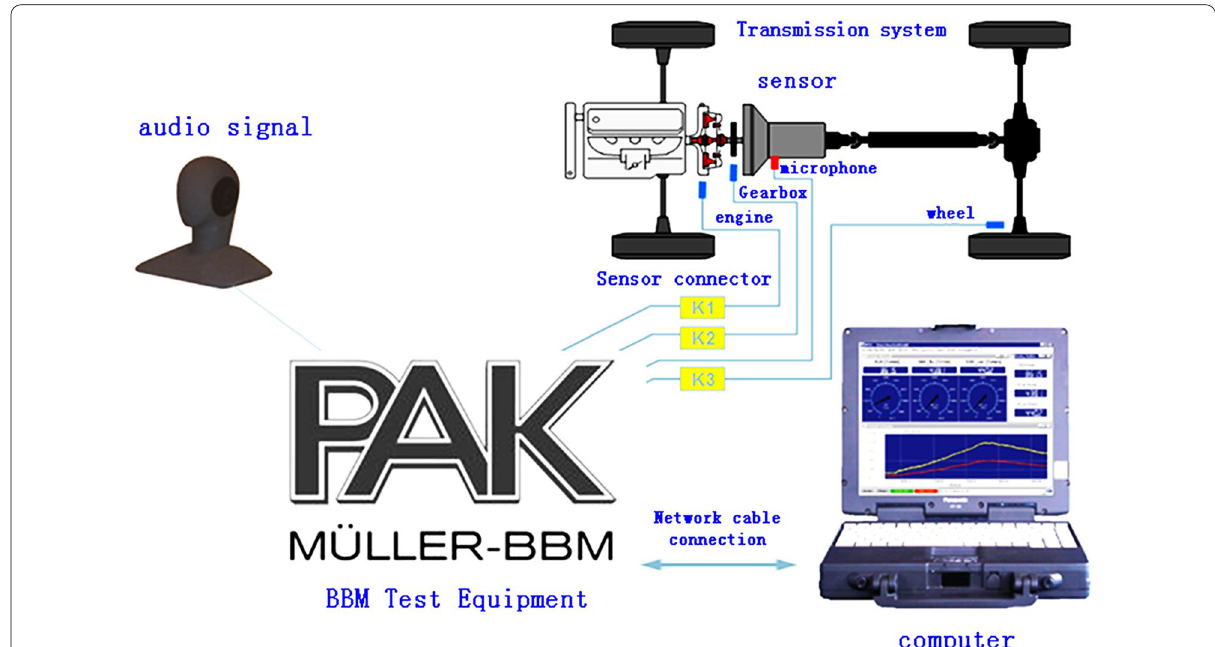
Figure 9 Torsional vibration/noise measurement and analysis system